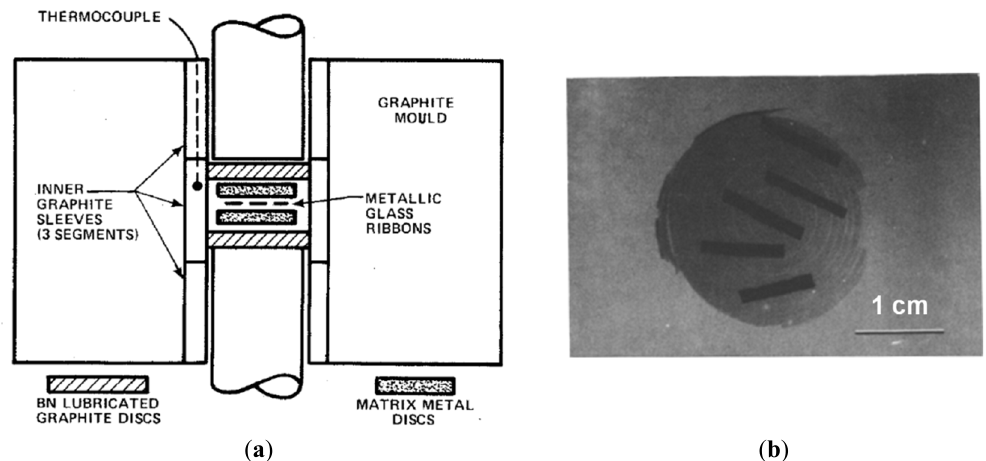
Figure 1. Schematic of the assembly for hot pressing of the ribbons with metal discs ( a ) and a radiograph of the hot-pressed sample ( b ). Reprinted from [29], Copyright (1982), with permission from Springer Nature: Chapman and Hall, Ltd.